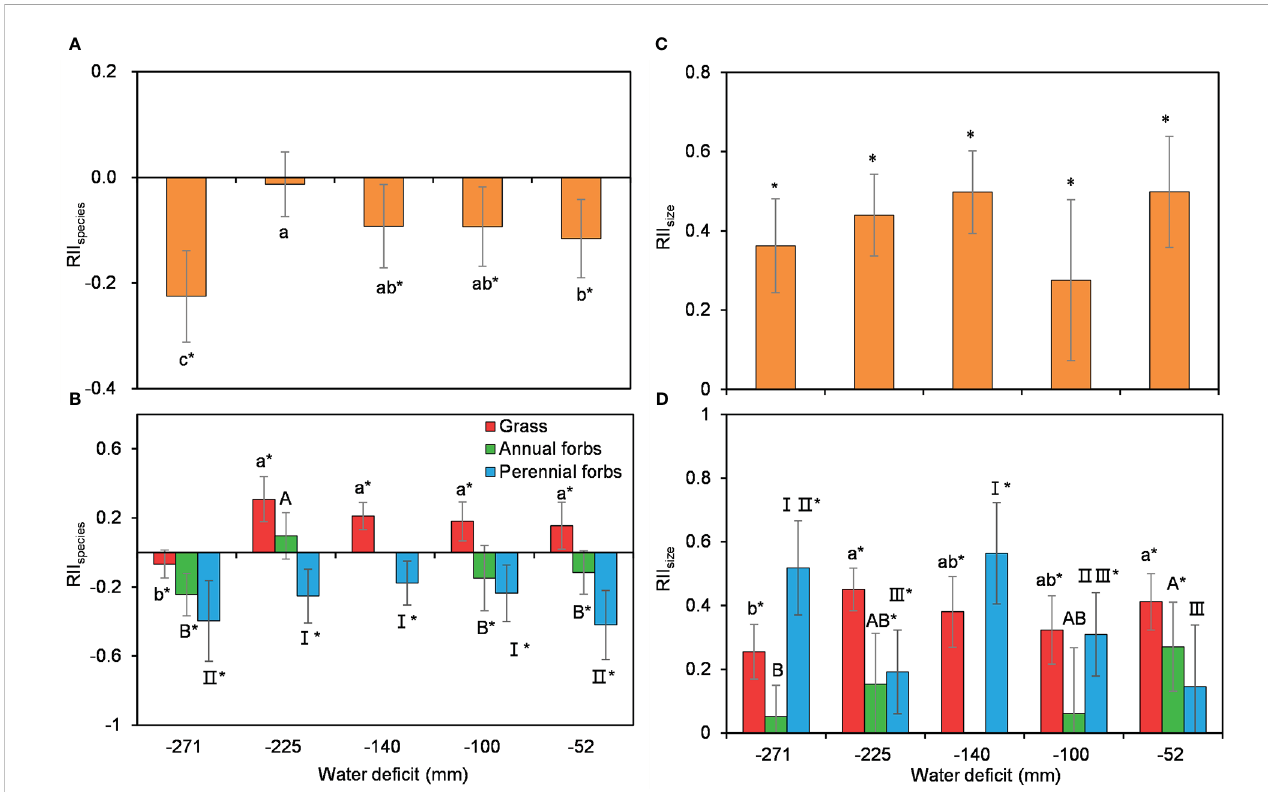
FIGURE 3 Variations in the interaction effects between Caragana versicolor and understory species assessed by species richness RII species (A, B) and plant size RII size (C, D) for total associated species (a and c) and across different functional groups (b and d) along the water de fi cit gradient in drylands of Tibetan Plateau. Different letters and roman numbers indicate signi fi cant differences in RII species or RII size between sites; asterisks show that RII species or RII size is signi fi cantly different from